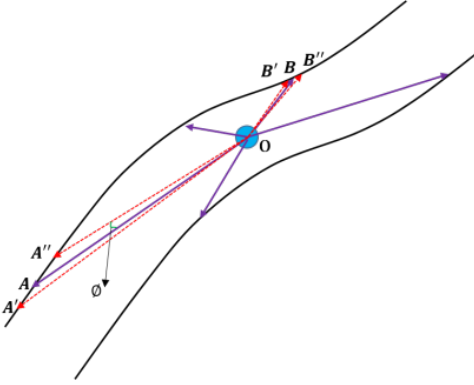
Figure 3. Ranging error description of 3D LIDAR.